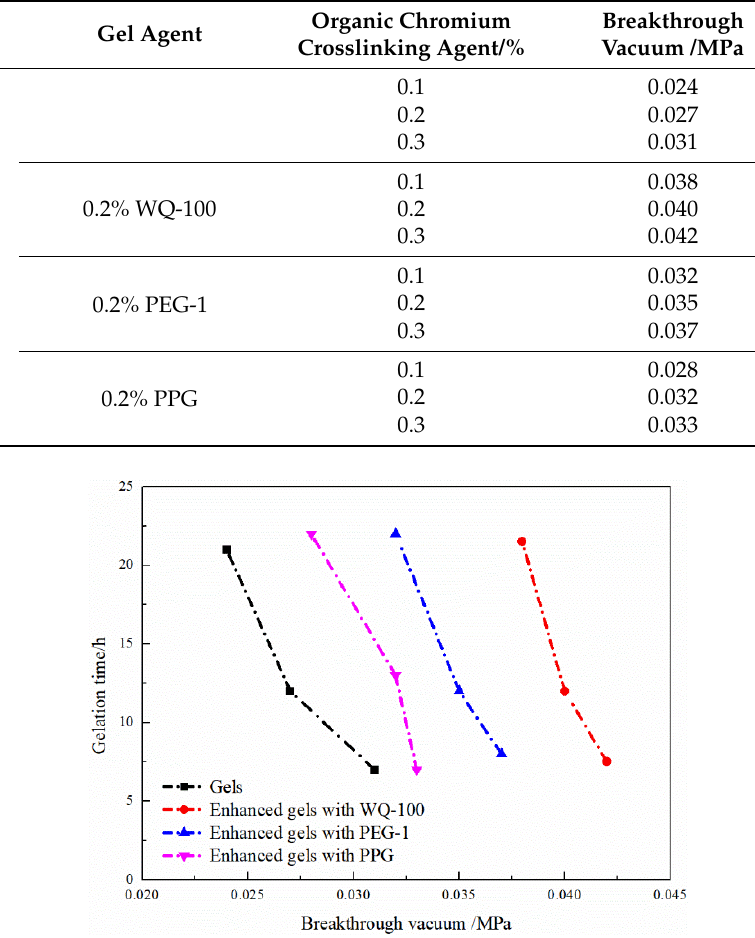
Figure 9. Gels strength and gelation of enhanced gels systems.